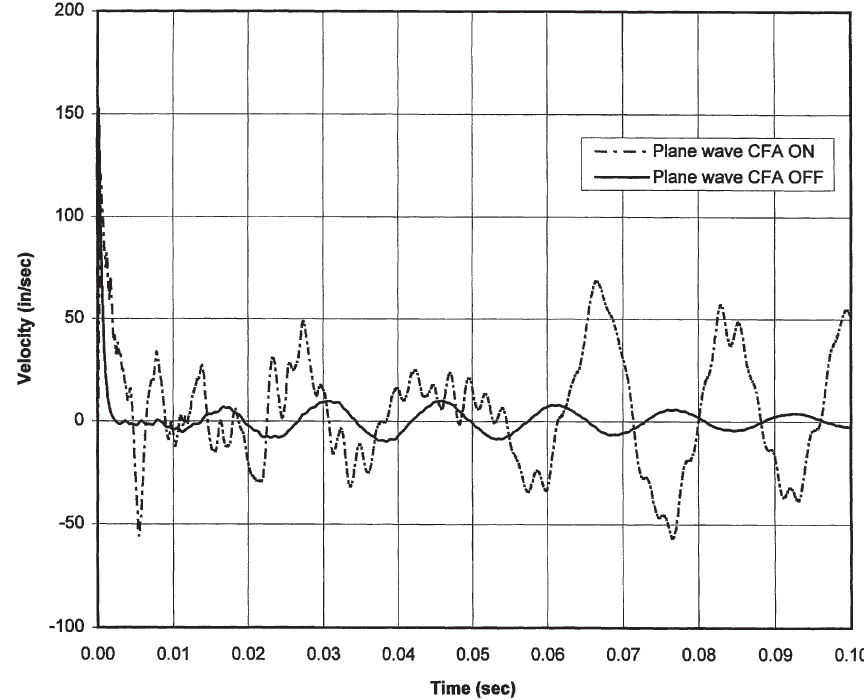
Fig. 10(a). Velocity response at the keel (node 42) for two cases: plane wave/CFA-on, and plane